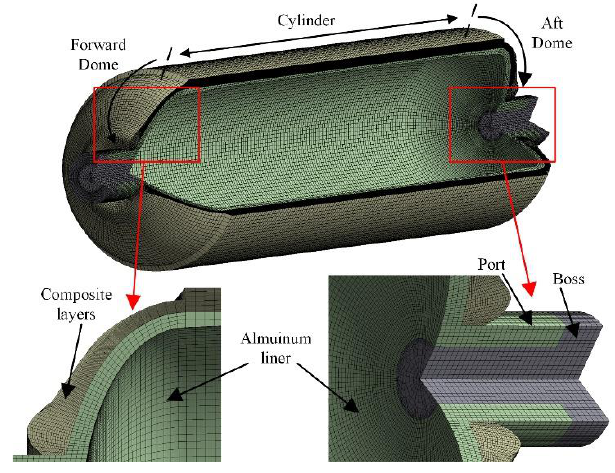
Figure 7. Finite-element model of the composite hydrogen storage vessel.